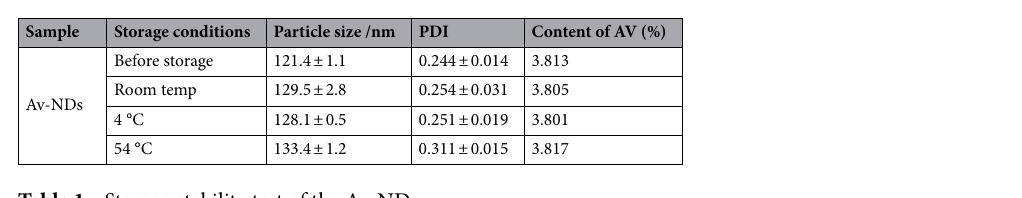
Table 1. Storage stability test of the